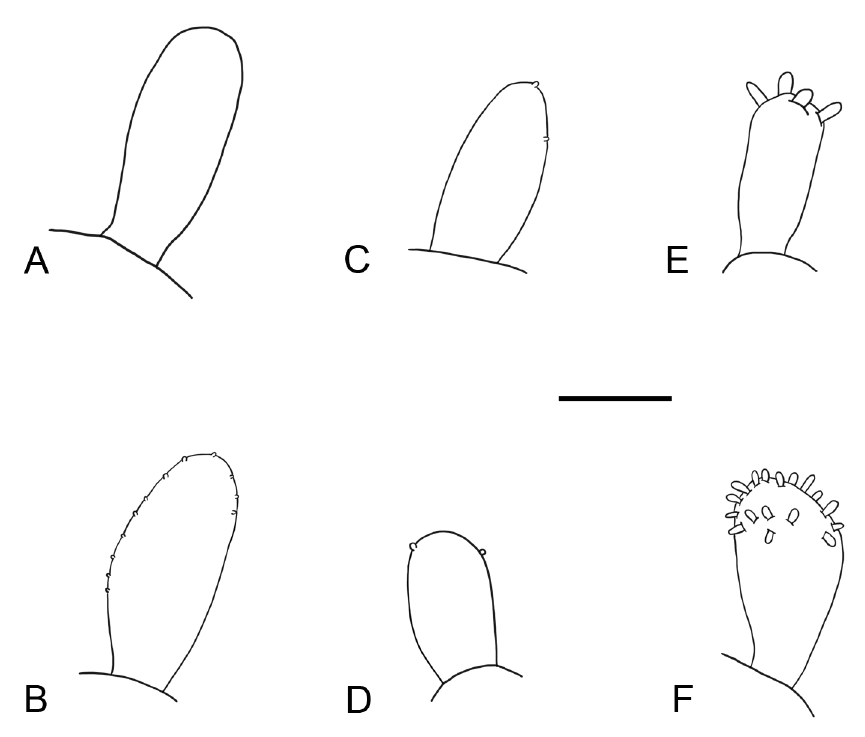
Fig. 5. Comparison of stylodes. A–D . Sthenelais boa (Johnston, 1833), TUM 39683. A . Large specimen, width 6 mm, segment 21. B . Same, segment 4. C . Medium specimen, width 4 mm, segment 21. D . Small specimen, width 3 mm, segment 21. E . Fimbriosthenelais longipinnis (Grube, 1869), SMF 24345, width 2.5 mm, segment from mid-body. F . Fimbriosthenelais zetlandica (McIntosh, 1876), TUM 36747, width 4 mm, segment 20. Scale bar: